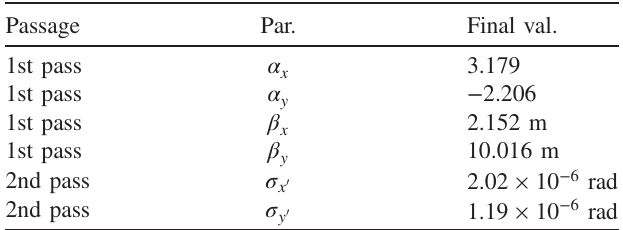
TABLE IV. Beam parameters obtained with the matching line after the first passage (BAC matching conditions) and the controlled beam divergence in the second passage. Passage Par. Final